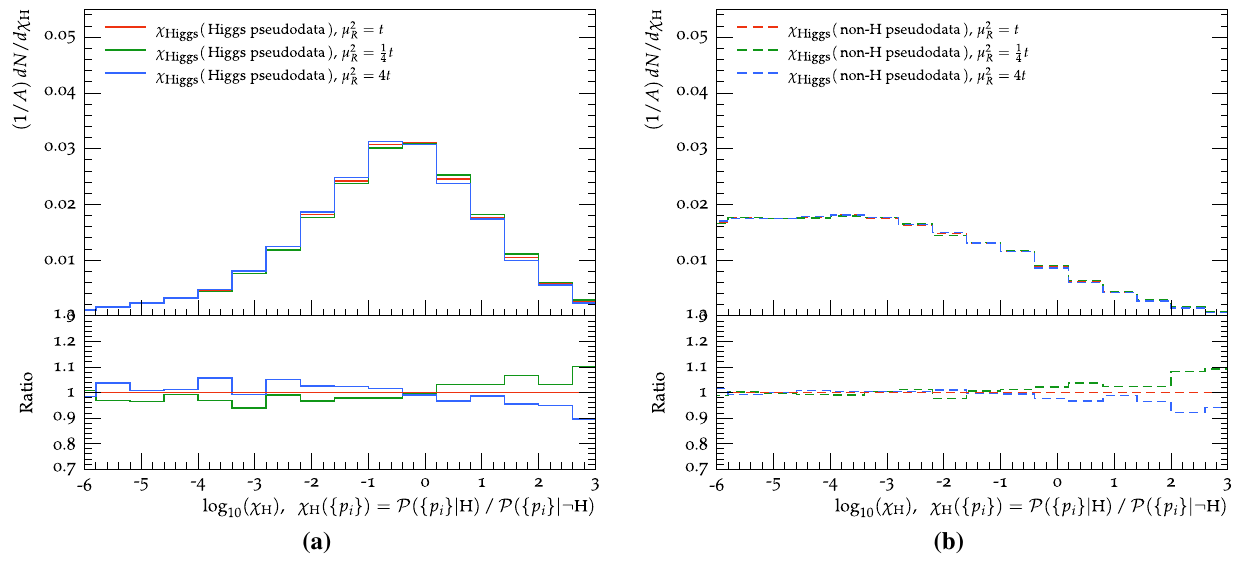
Fig. 2 Classification of signal or background pseudodata according to Higgs hypothesis, using different values for the argument of the QCD running coupling, both in the evaluation of coupling factors as well as the evaluation of no-branching